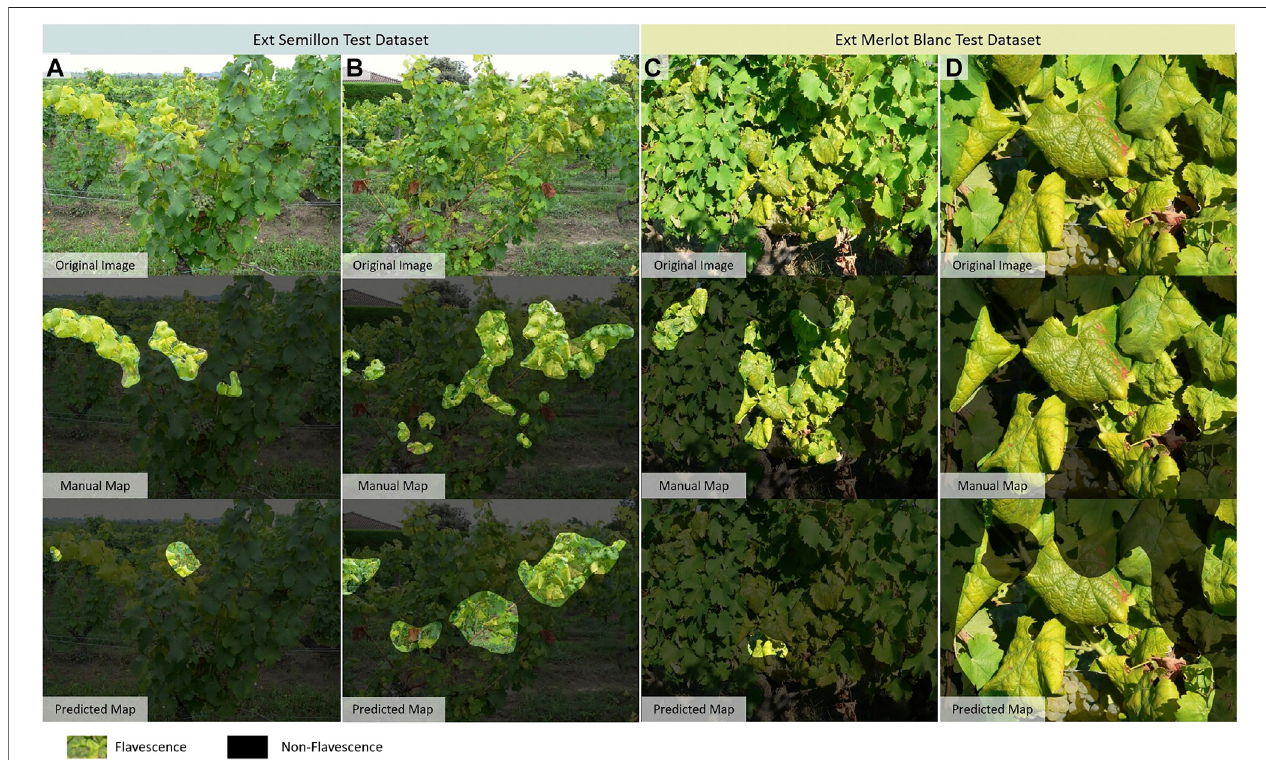
FIGURE 8 | Segmentation maps with minimum and maximum Intersection over Union (IoU) values on two Ext. datasets. On the Ext. Semillon dataset: Images (A) with the lower IoU value, and (B) with the higher IoU value. On the Ext. Merlot Blanc dataset: (C) with the lower IoU value, and (D) with the higher IoU